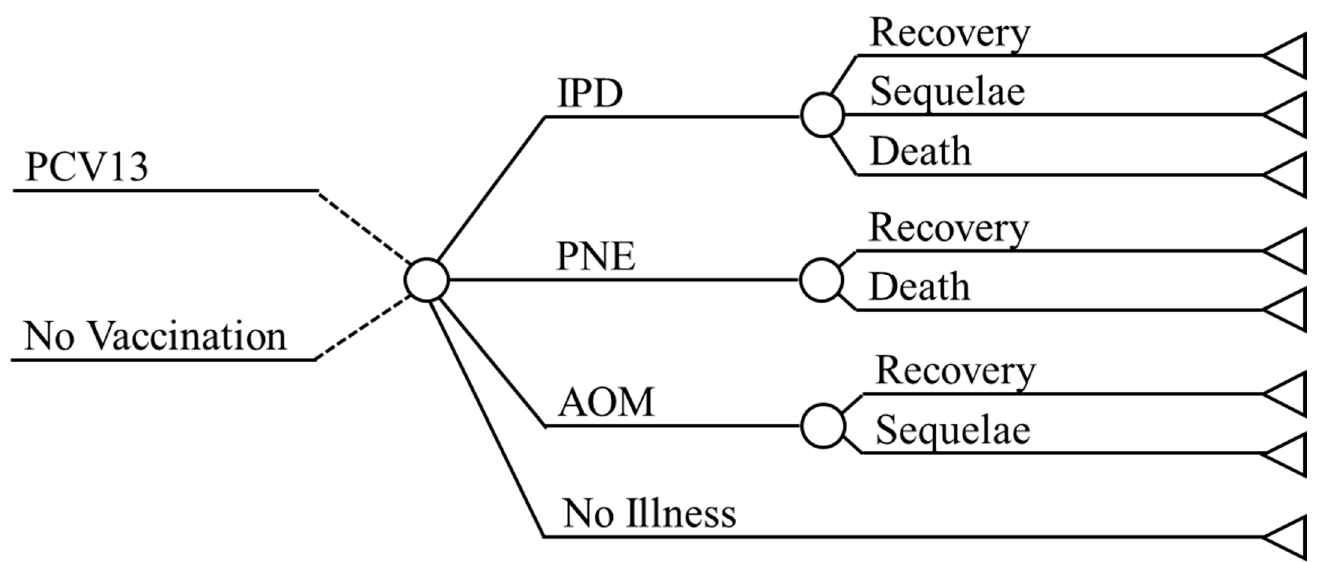
Figure 1. Model Design. Abbreviations: PCV = Pneumococcal conjugate vaccine; IPD = Invasive pneumococcal diseases; PNE = Pneumonia; AOM = Acute otitis media.